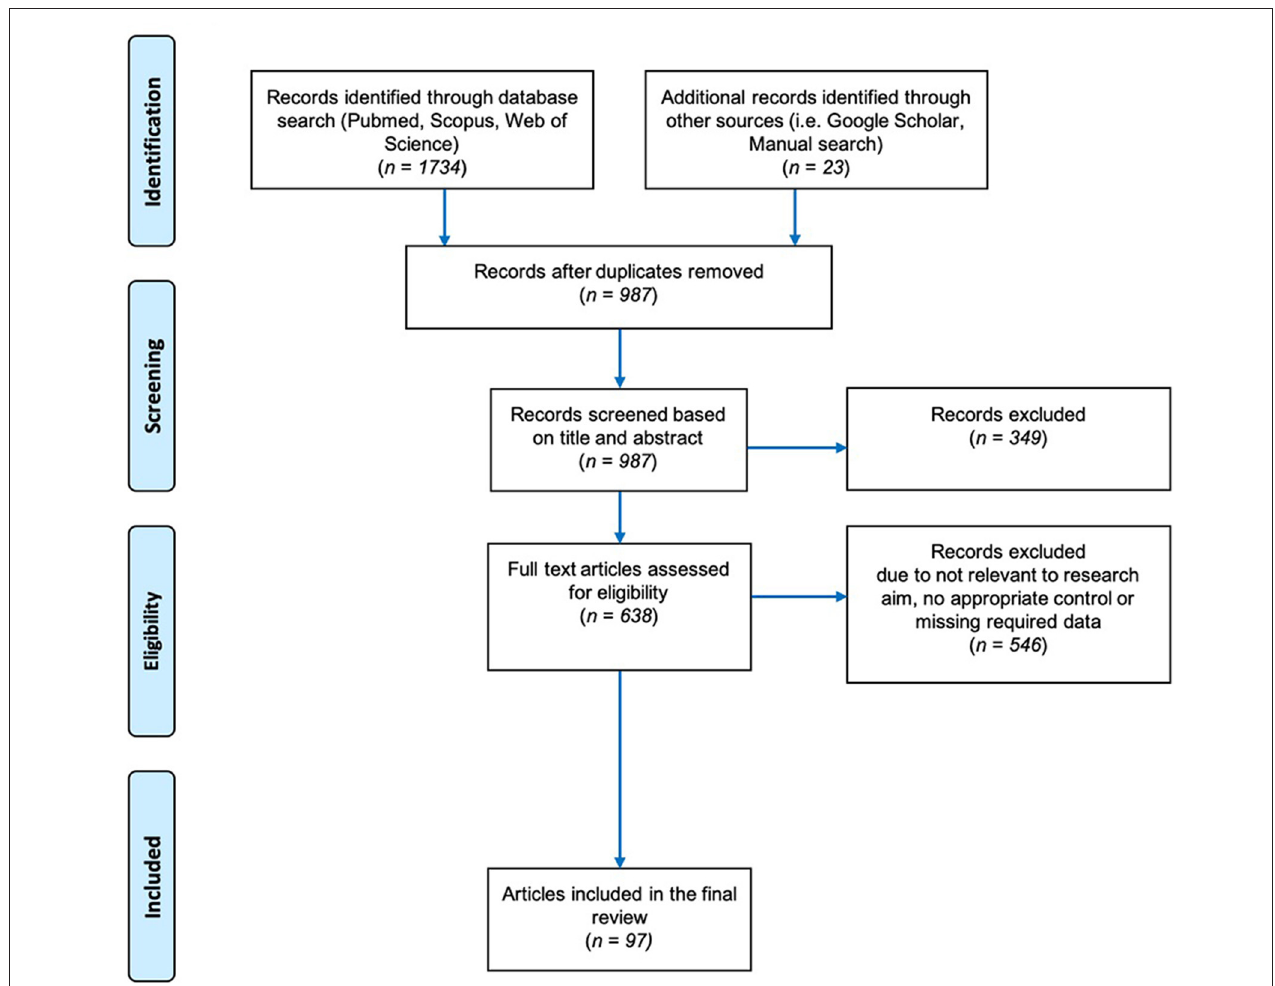
FIGURE 2 | Preferred Reporting Items for Systematic Reviews and Meta-Analysis (PRISMA) Flow Chart describing the search protocol utilized to identify and select published research for this